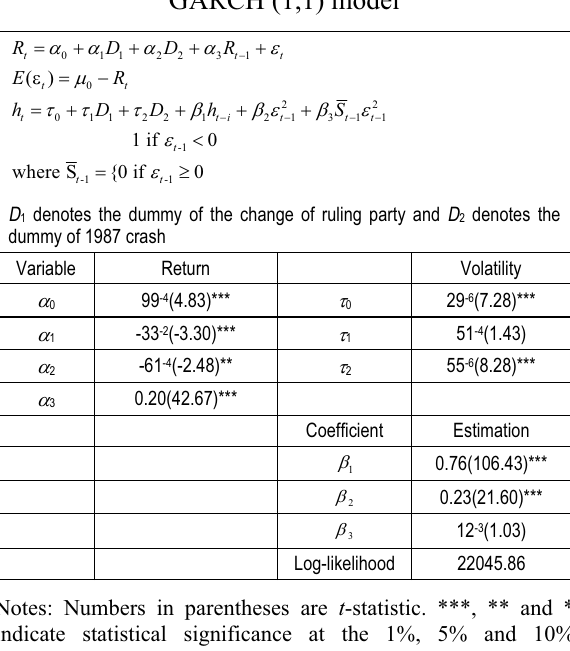
coefficient of the previous day’s negative noise,